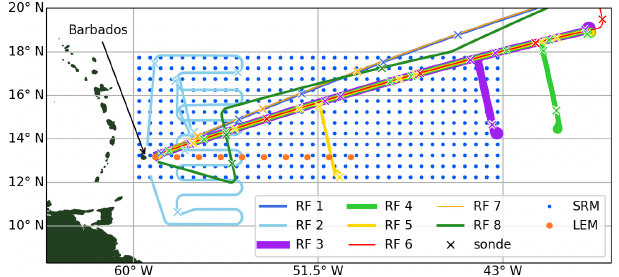
Figure 1. Map showing research flight (RF) tracks and the model columns that are used in this study. The storm-resolving model (SRM, blue, original model grid spacing: 1.25km) is thinned to a 0.5 ◦ × 0.5 ◦ grid. From the large-eddy model (LEM, orange, origi- nal model grid spacing: 300m), 10 meteogram outputs are